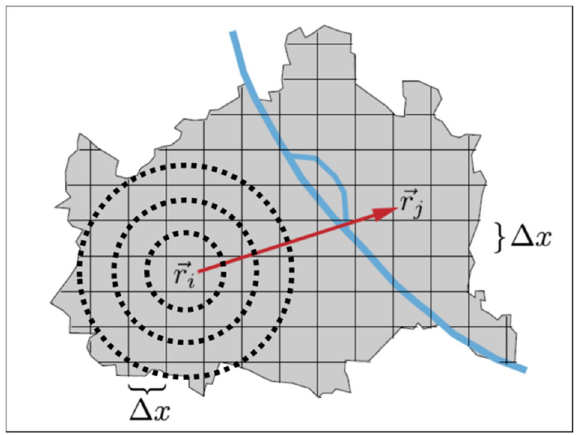
Fig. 1 Conception of study area. Schematic concept of a region described as a grid structure of locations, origin r i visualisation of possible destinations at the same travel distance